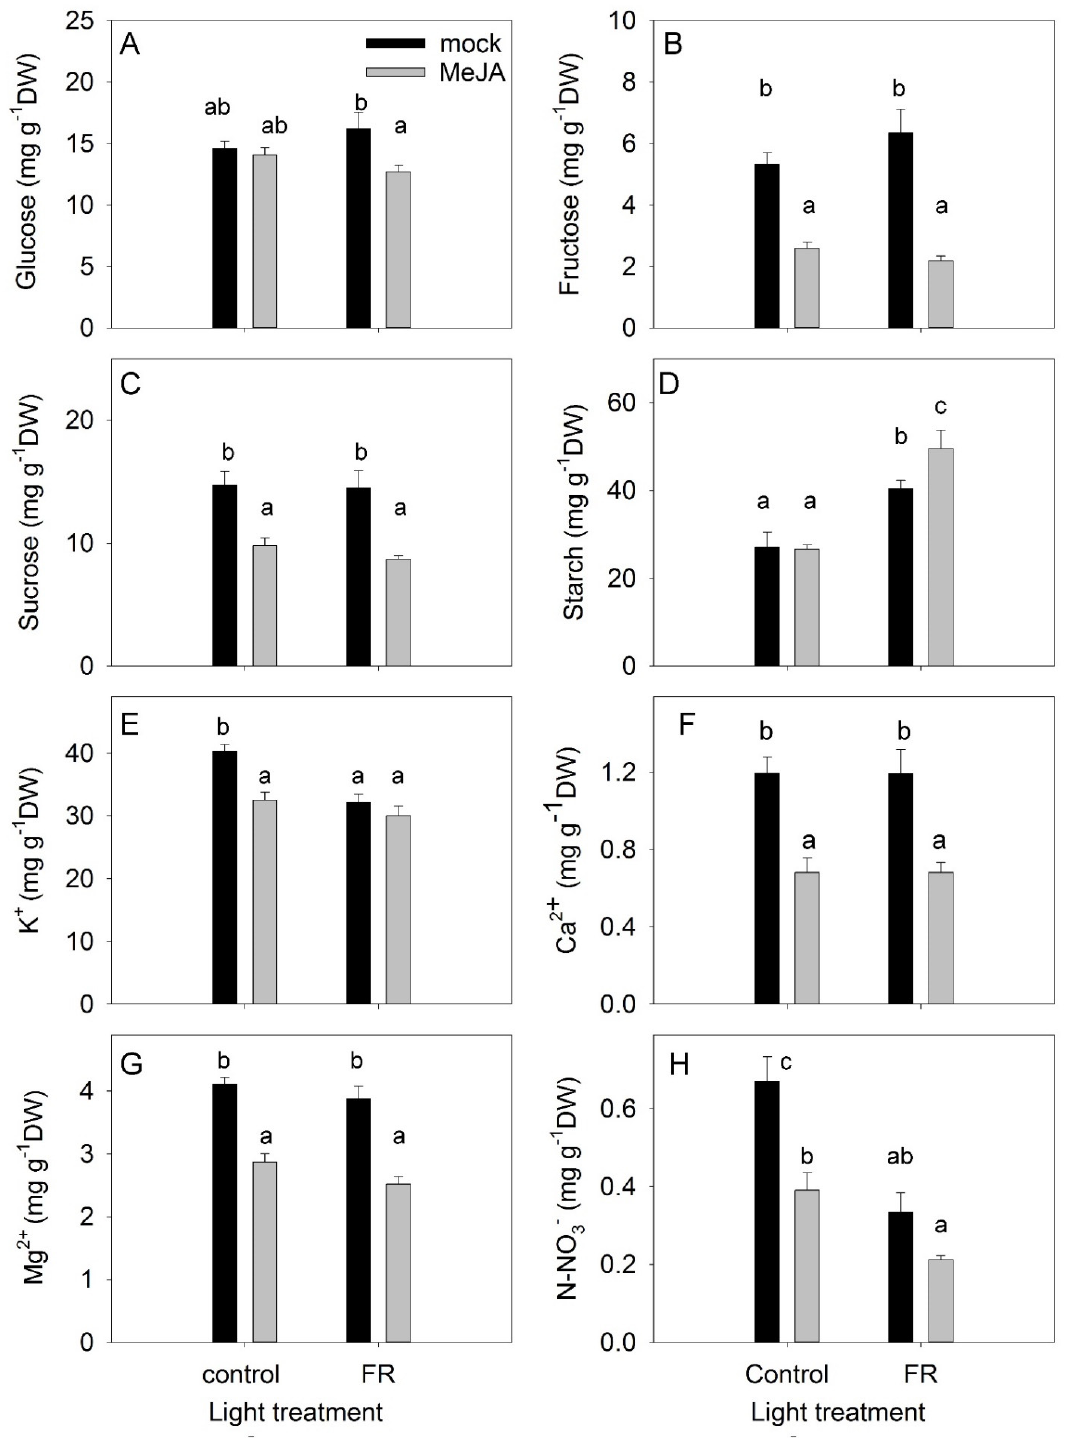
Figure 5. The effect of far-red light and methyl jasmonate (MeJA) application on glucose ( A ), fructose ( B ), sucrose ( C ), starch ( D ), potassium ( E ), calcium ( F ), magnesium ( G ), and nitrate ( H ) concentrations in leaves of Hypericum perforatum plants. Differences between means with different letters are statistically significant. H. perforatum seedlings were given different light and hormone treatments at 36 days after sowing (DAS). The final plant samples were taken at 65